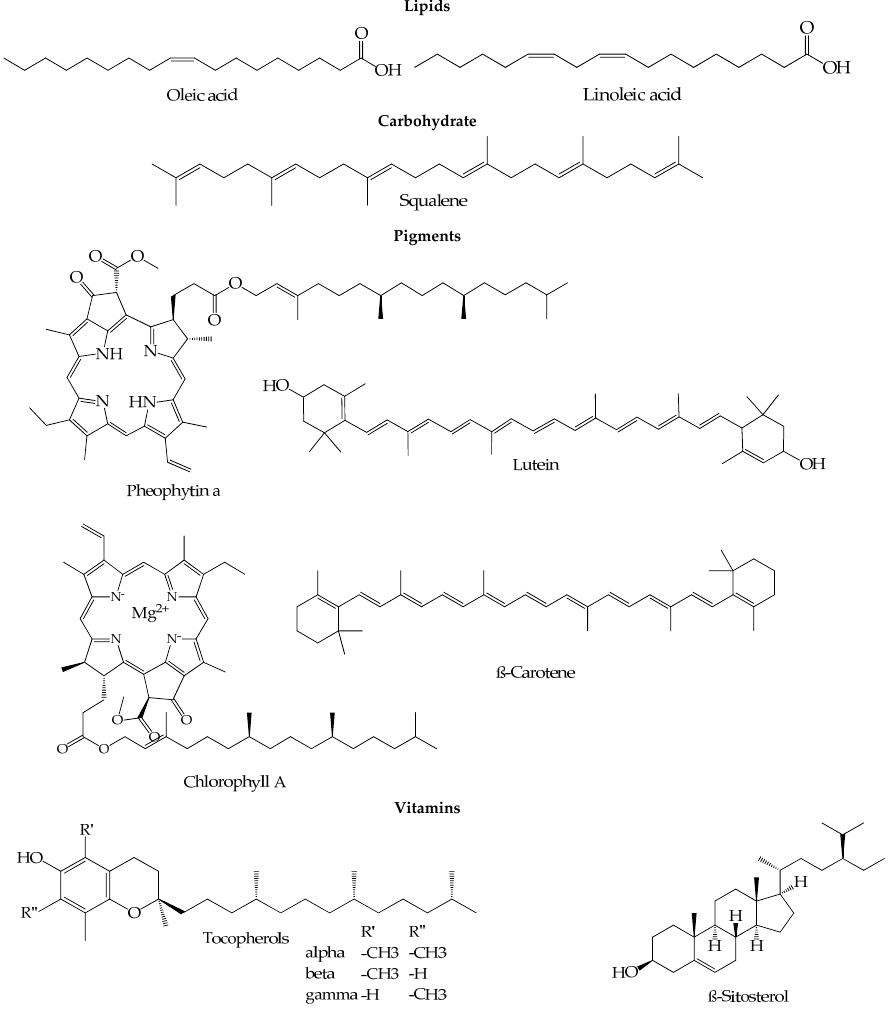
Figure 3. Representative chemical structures of some relevant compounds present in EVOO.